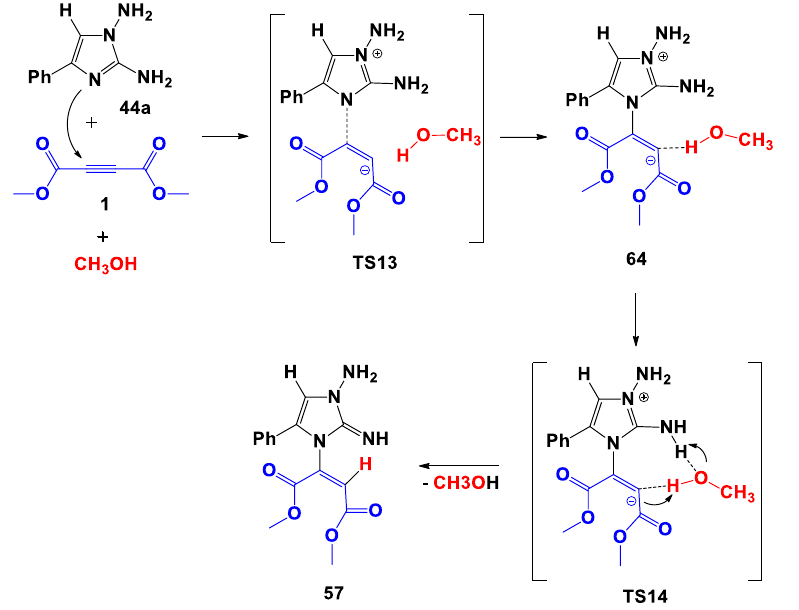
Scheme 14. Proposed trimolecular formation mechanism of 57 .